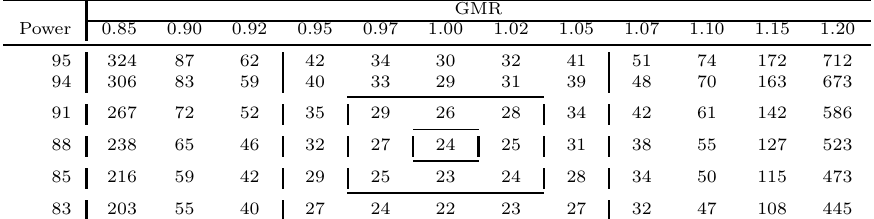
Sample size variations for different Power and GMR values